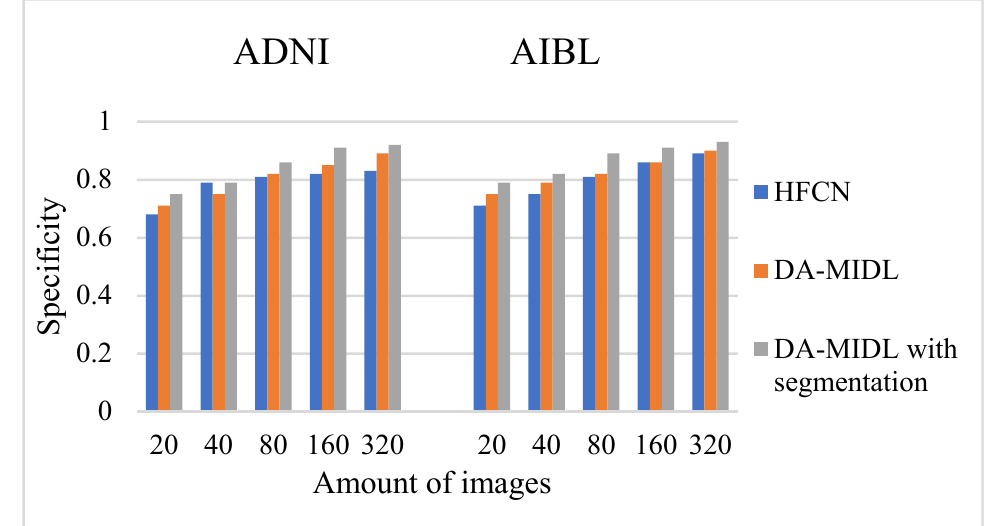
Figure 6. Specificity comparison outcomes between DA-MIDL, HFCN, and proposed DA-MIDL with segmentation.